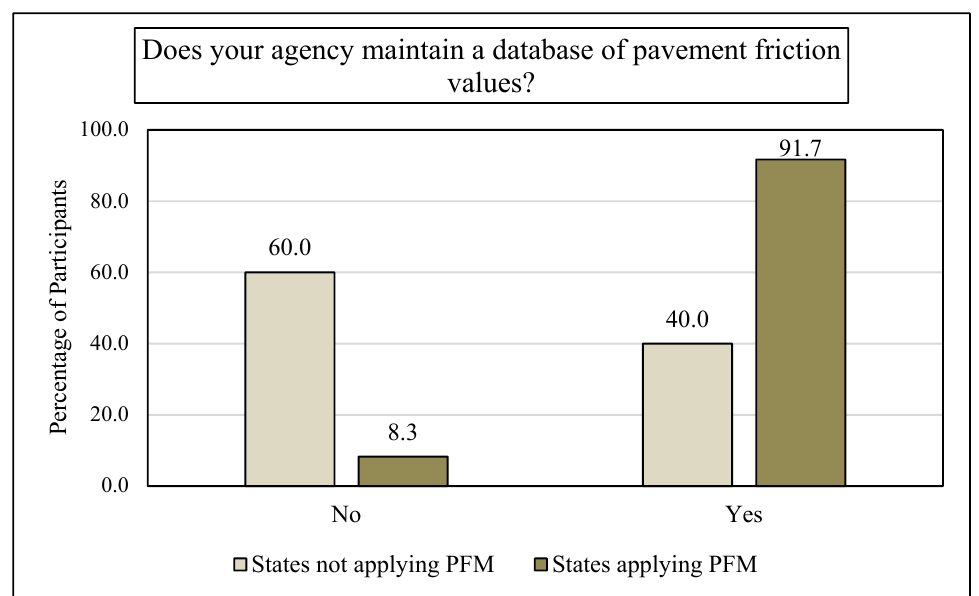
Figure 11. State DOT practices of maintaining a database for pavement friction measurements.